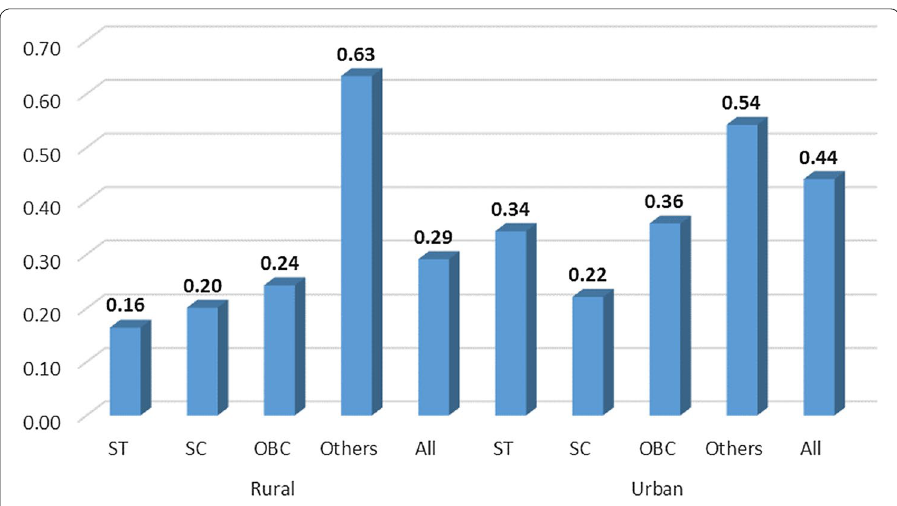
Fig. 2 Gini coefficients across various social groups of